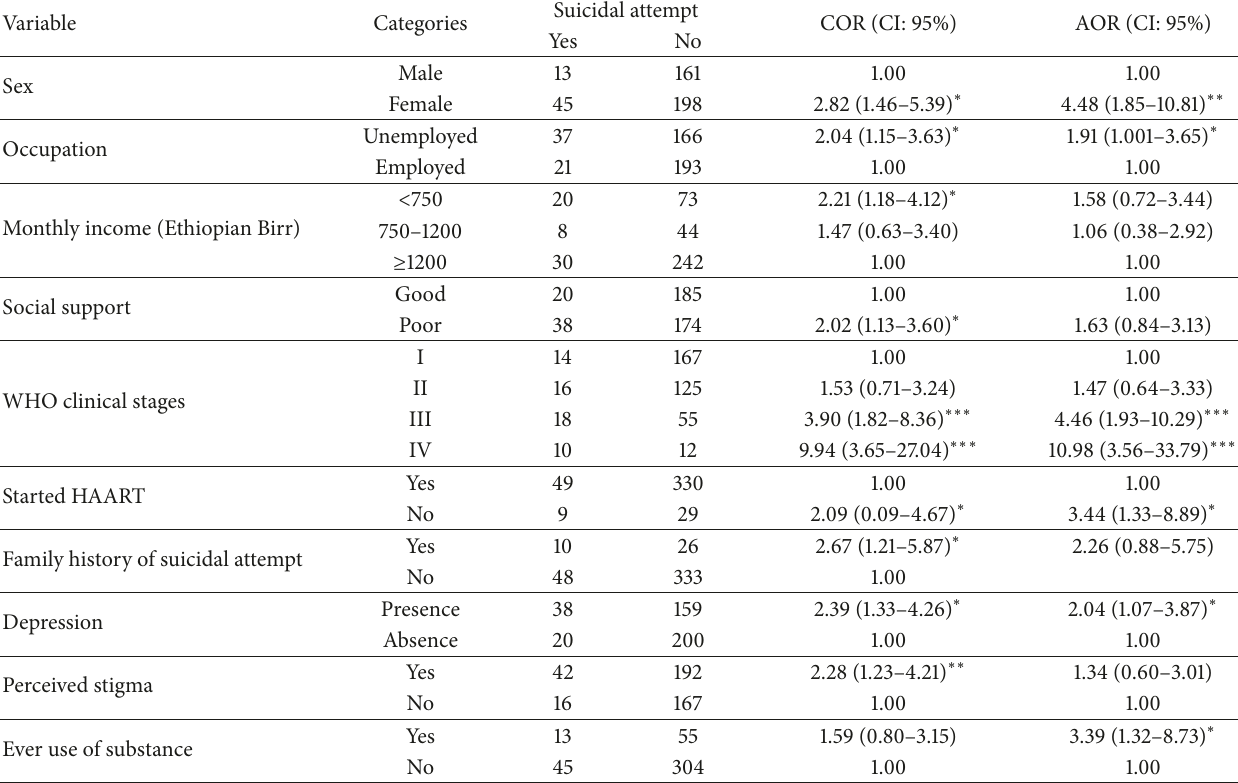
Table 3: Logistic regression analysis of factors associated with suicidal attempt among HIV-positive people at Zewditu Memorial Hospital, Addis Ababa, Ethiopia, June